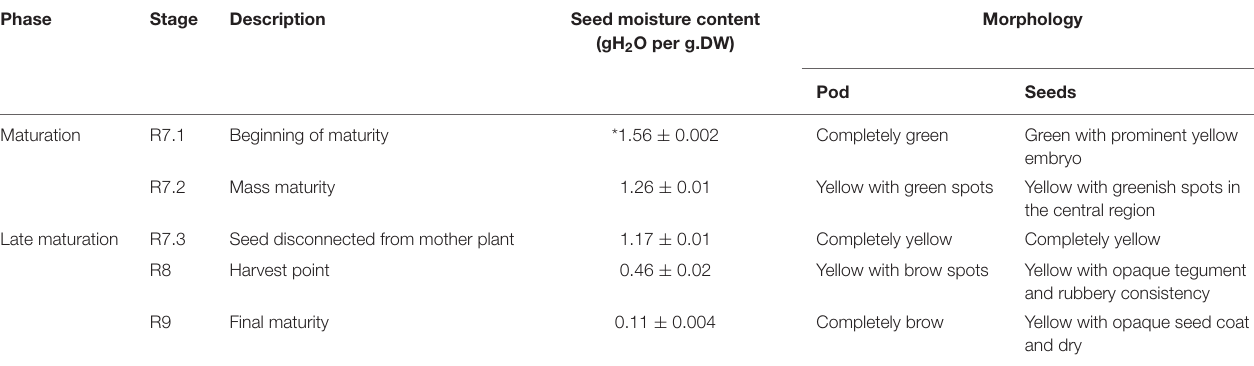
TABLE 1 | Description of soybean seed maturation stages, and the corresponding seed moisture content and morphological characteristics of pods and seeds used in this study. Phase